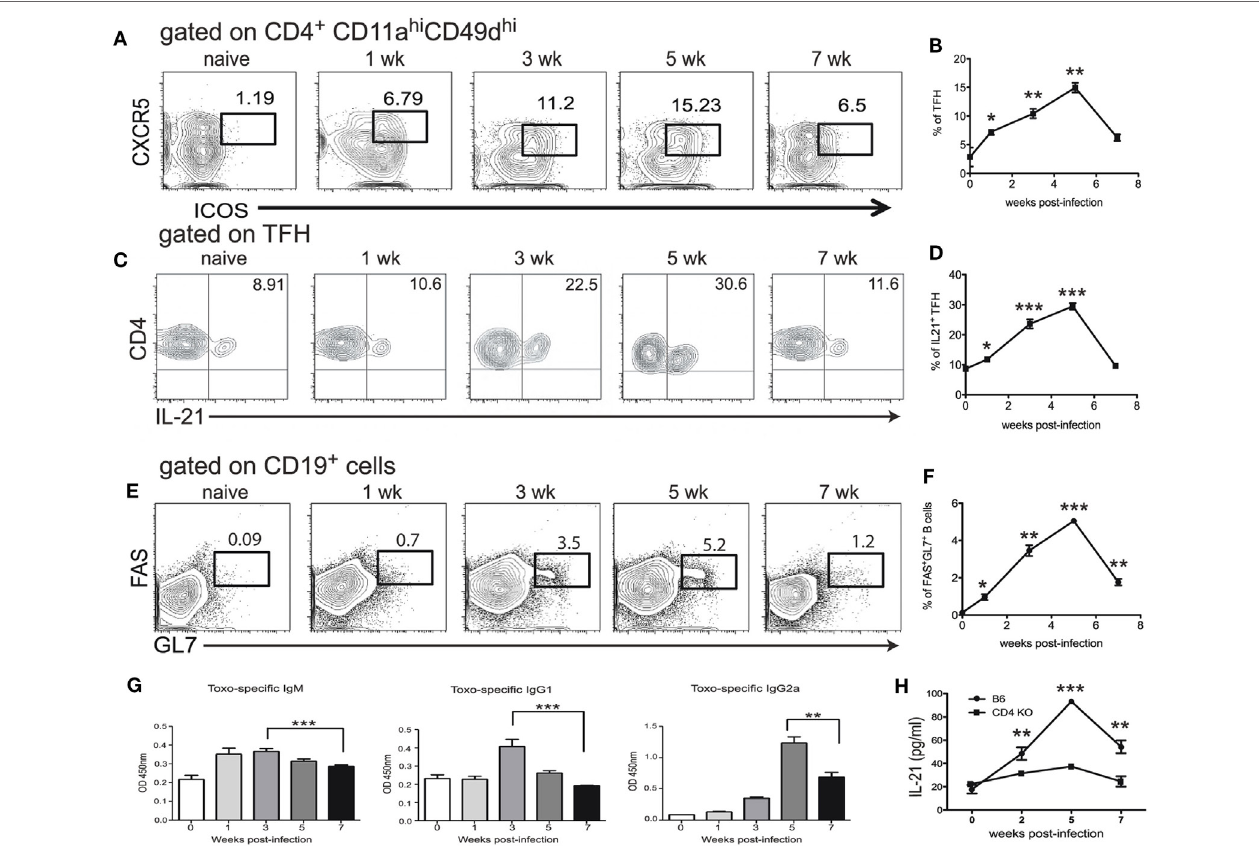
FigUre 1 | T follicular helper cell (Tfh) response is impaired during chronic toxoplasmosis. C57Bl/6 mice were orally infected with 10 T. gondii cysts. Antigen- specific Tfh (ICOS hi CXCR5 hi ) were assessed in the spleen at different time points post infection (weeks 1, 3, 5, and 7 p.i.) (a,B) . Plots are gated on antigen-specific CD4 T cells (CD11a hi , CD49d hi ) (a) . The graph represents the percentage of Tfh among antigen-specific CD4 T cells (B) . IL-21 producing Tfh were measured by intracellular staining in the spleen of infected WT animals at weeks 1, 3, 5, and 7 p.i. and plots are gated on antigen-specific Tfh at different time points post infection (ICOS hi CXCR5 hi CD11a hi CD49d hi CD4 T cells) (c) . The graph represents the percentage of IL-21-producing cells among Tfh (D) . B cells (CD19 + ) were stained for germinal center markers (GL7 and FAS) at the same time points (e) . The graph shows the percentage of CD19 + cells that express GC markers GL7 and FAS (F) . T. gondii -specific IgM, IgG1 and IgG2a from sera of infected animals were measured by ELISA at week 1, 3, 5, and 7 p.i. (g) . Levels of IL-21 in the serum of infected C57Bl/6 and CD4 KO mice were measured by ELISA (h) . Experiments were carried out at least twice and data are representative of one experiment. Student’s t -test was used to compare each time points to the naïve controls (* p ≤ 0.05; ** p ≤ 0.001; *** p ≤